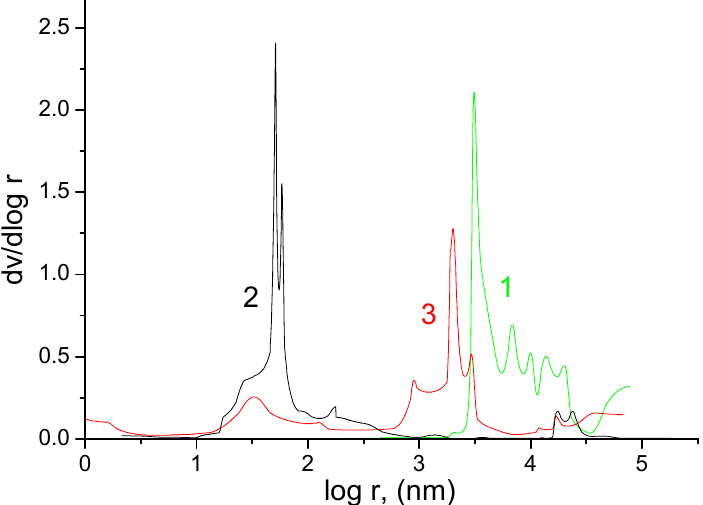
Figure 3. Differential curves of the distribution of pores along the radii obtained by MSCP for: 1—separator FS 2226; 2—Grace separators; 3—KU-F5-240 membranes.